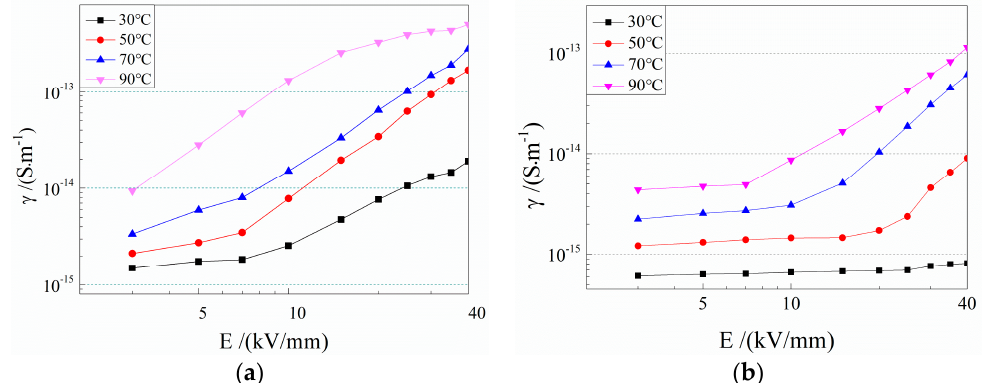
Figure 5. The electrical conductivity of ( a ) iPP/SEBS and ( b ) cPP- g -MAH/iPP/SEBS, as a function of electric field at 30–90 °C.